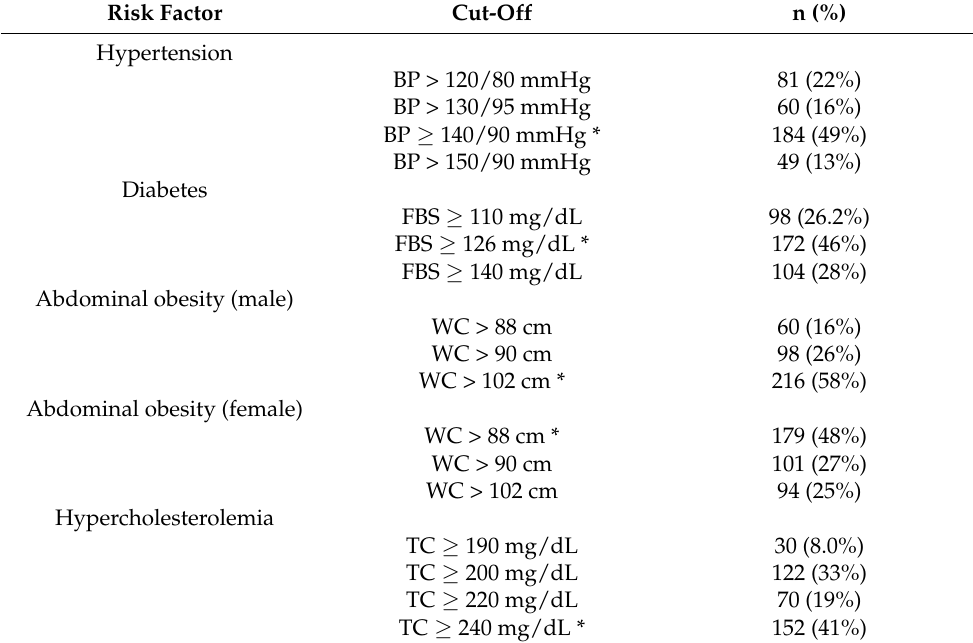
Table 3. Knowledge of diagnostic cut-offs for common cardiovascular disease risk